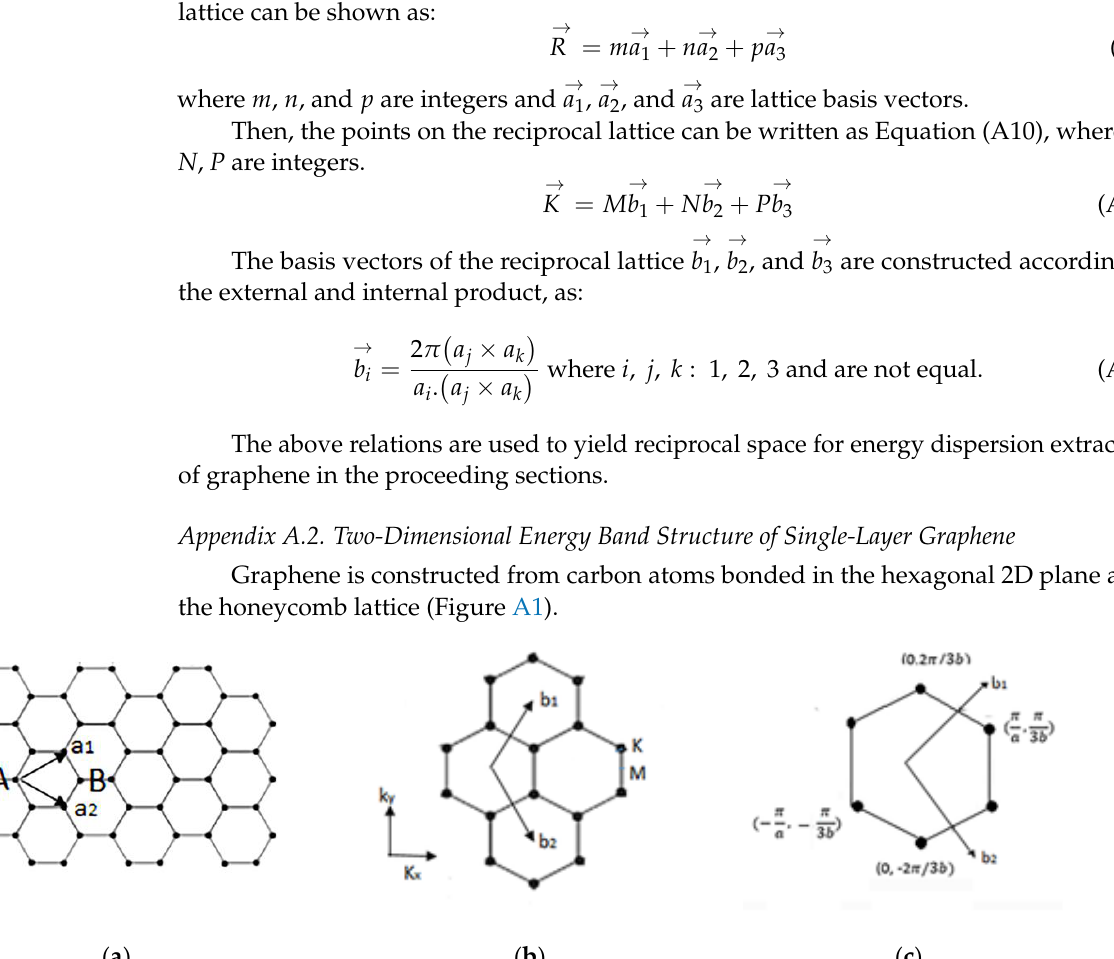
→ → a 1 , a 2 basis vectors; ( b ) reciprocal space and